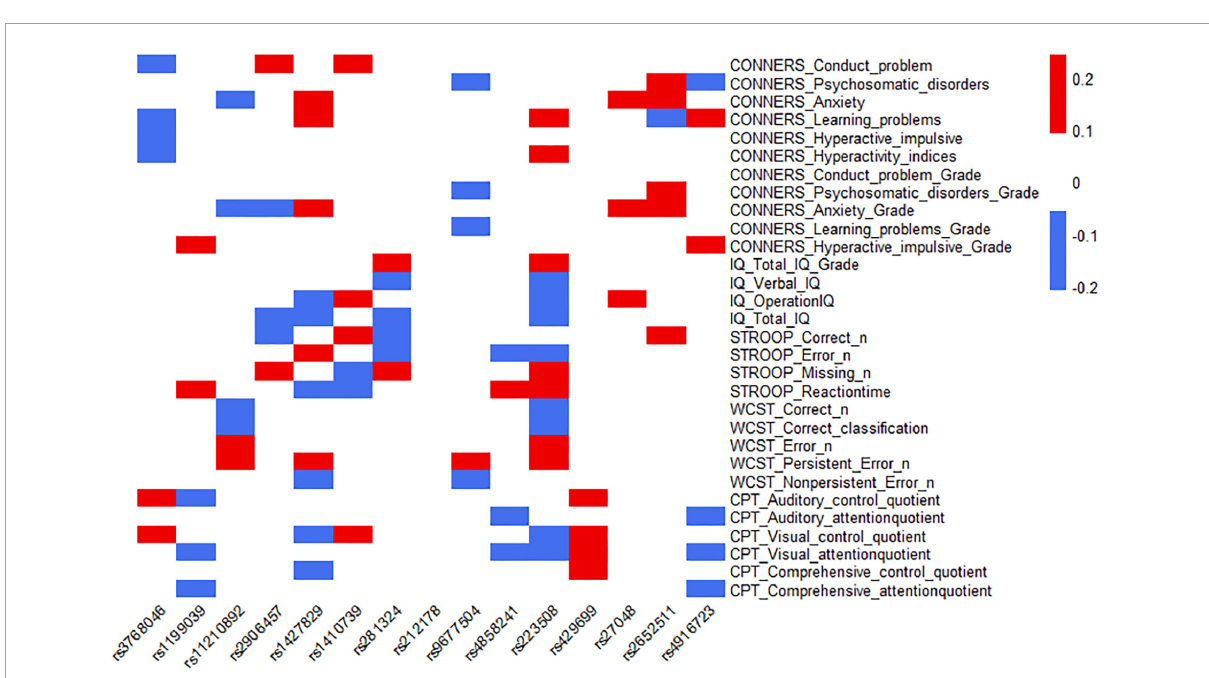
FIGURE4 Correlation analysis between SNPs and the severity of clinical symptoms of